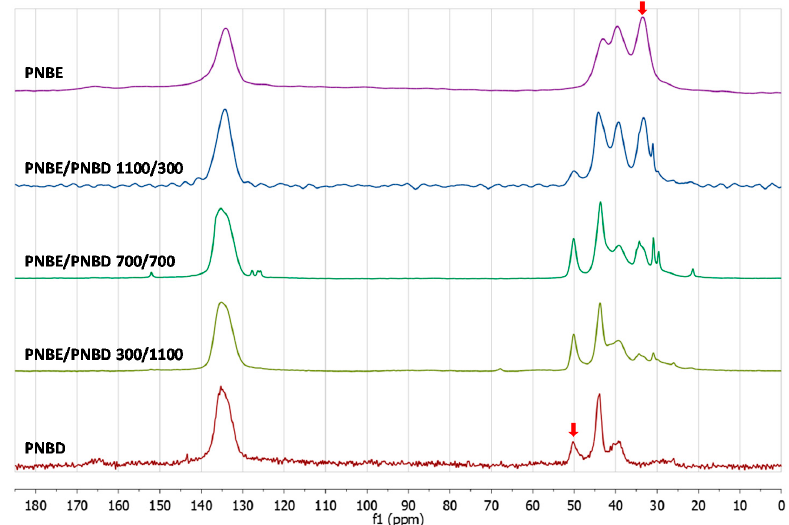
Figure 3. 13 C CPMAS NMR spectra of PNBE and PNBD homopolymers, and PNBE/PNBD copolymers with various NBE/NBD molar ratios, as indicated. Peaks characteristic and distinct for PNBE and PNBD are indicated with arrows.